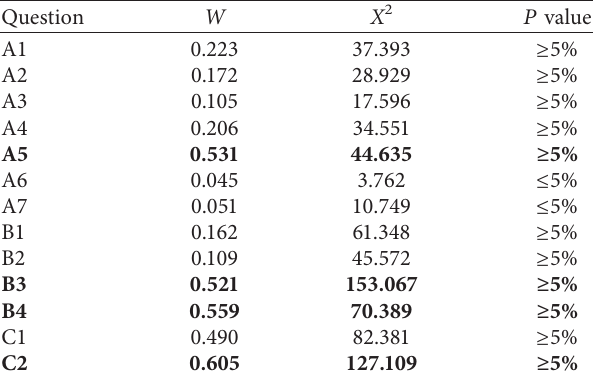
Table 3: Kendall’s test of